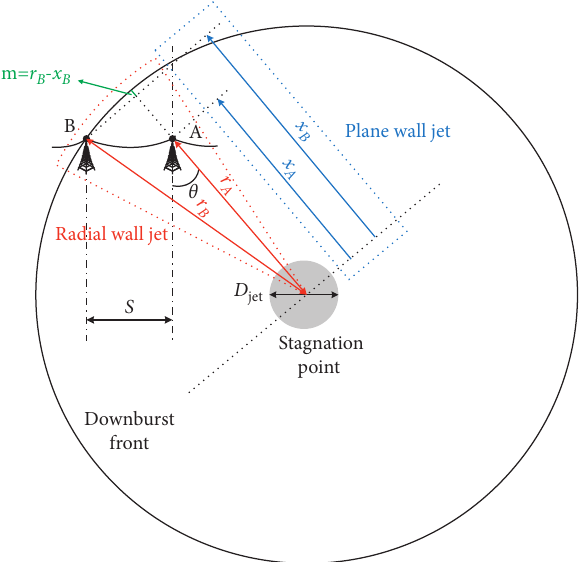
Figure 21: Horizontal projection of transmission tower and downburst.